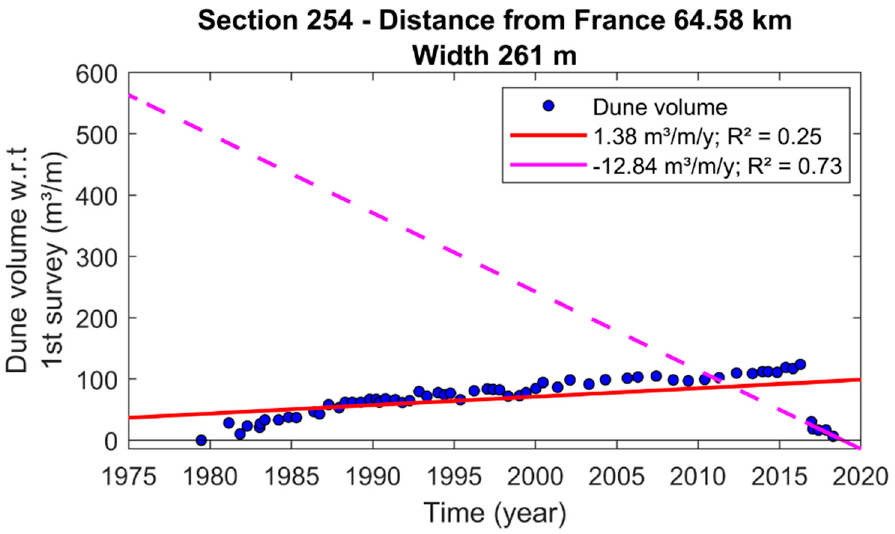
Figure 21. Decadal dune evolution of the coastal dunes at section 254. The solid magenta line indicates the recent dune trend.